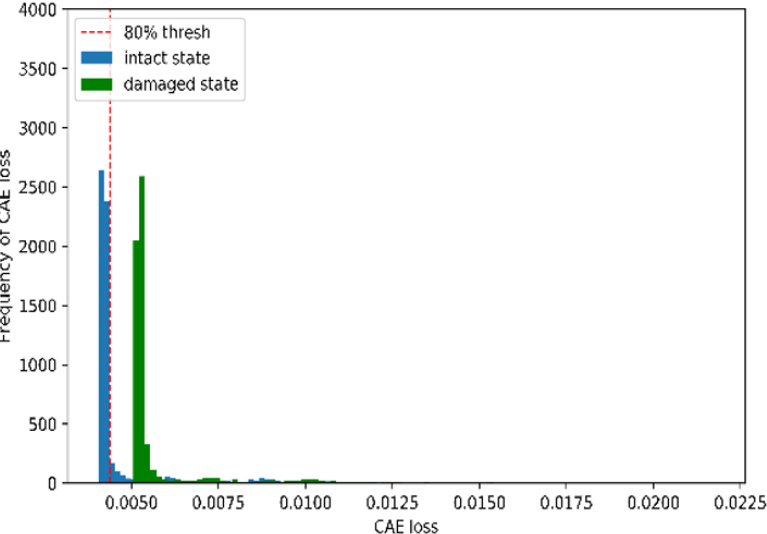
Figure 7. Example of histograms for CAE losses with each damage case and error level for rigid- frame-bridge modeling.